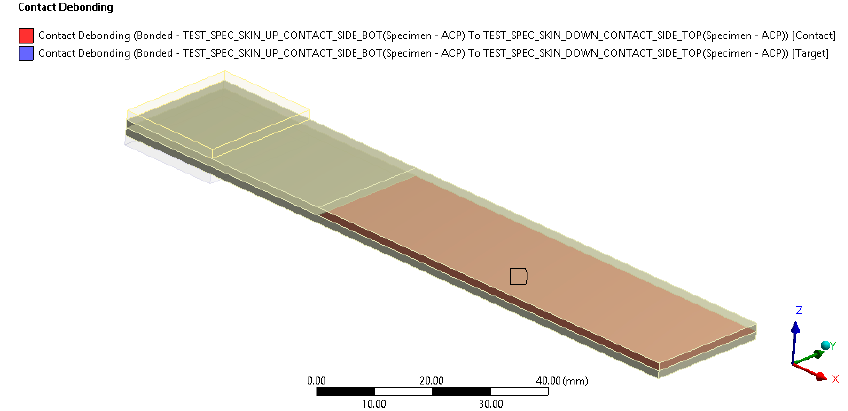
Figure 10. Contact debonding area in the specimen .